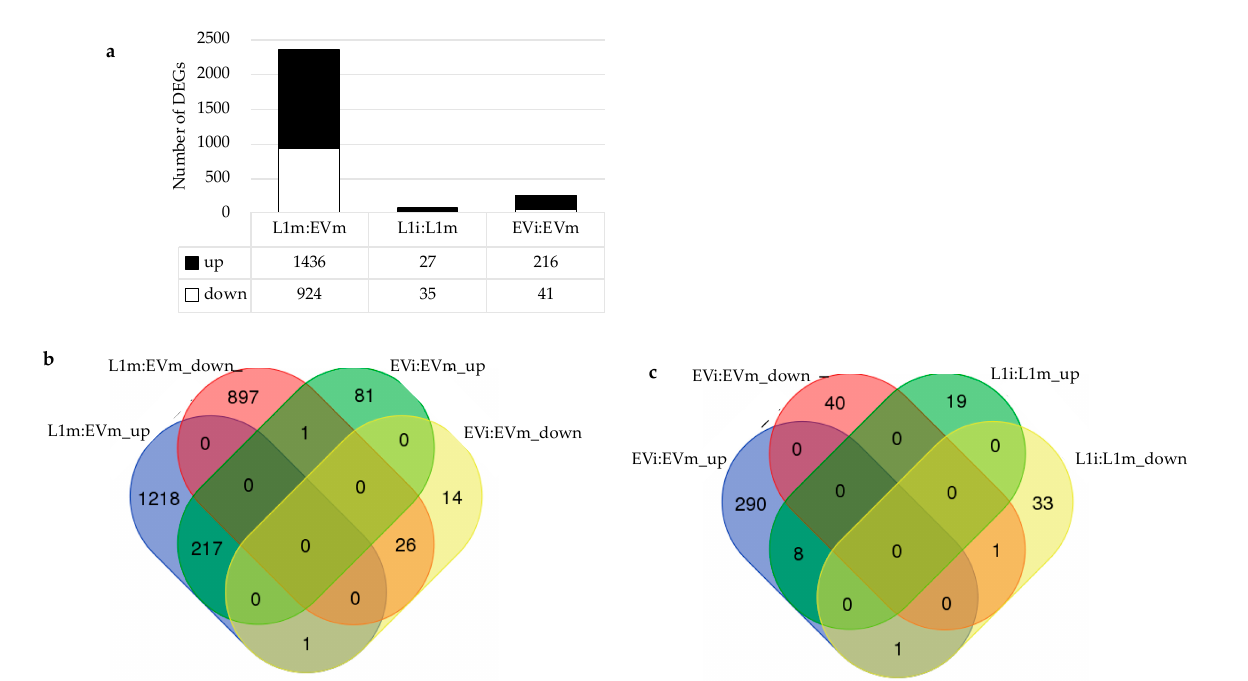
Figure 6. RNA-Seq analysis of transgenic plants expressing VriATL156. ( a ) Differentially expressed genes in mock-infected transgenic line L1 (L1m) vs. mock-infected empty-vector control plants (EVm), P. viticola -infected L1 (L1i) vs. L1m, and P. viticola -infected empty-vector control plants (EVi) vs. EVm. ( b ) Venn diagram showing the overlap between genes constitutively overexpressed in L1 and control plants and the genes induced in control plants by infection with P. viticola. ( c ) Venn diagram showing the overlap between genes modulated in infected L1 plants and genes modulated in infected controls. DEGs, differentially expressed genes.